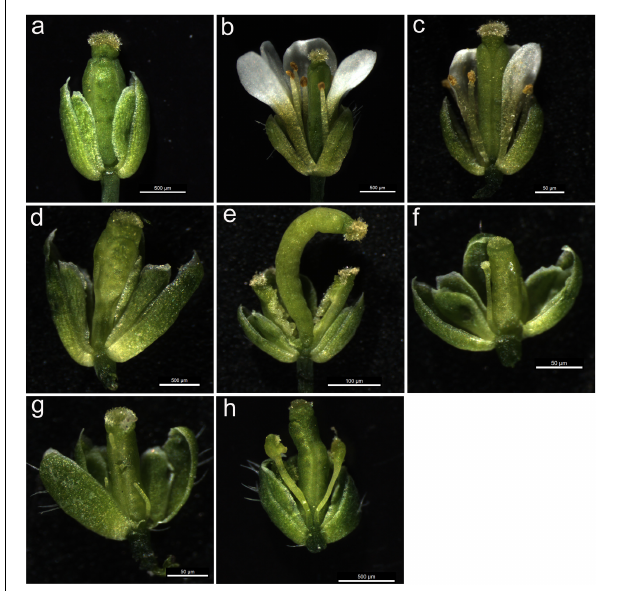
FIGURE 5 | The mature flowers of transgenic plants ectopically expressing MAwuPI in Arabidopsis pi-1 mutant. (a) The flower of pi-1 homozygous Arabidopsis thaliana . (b) The flower of wild-type Arabidopsis thaliana . (c) The flower of pi-1 heterozygous Arabidopsis thaliana . For a better view, one of the petals has been removed. (d–h) 35S::MAwuPI transgenic Arabidopsis in pi-1 mutant background (line 4 # , 5 # , 6 # , 7 # , and 8 # , respectively).